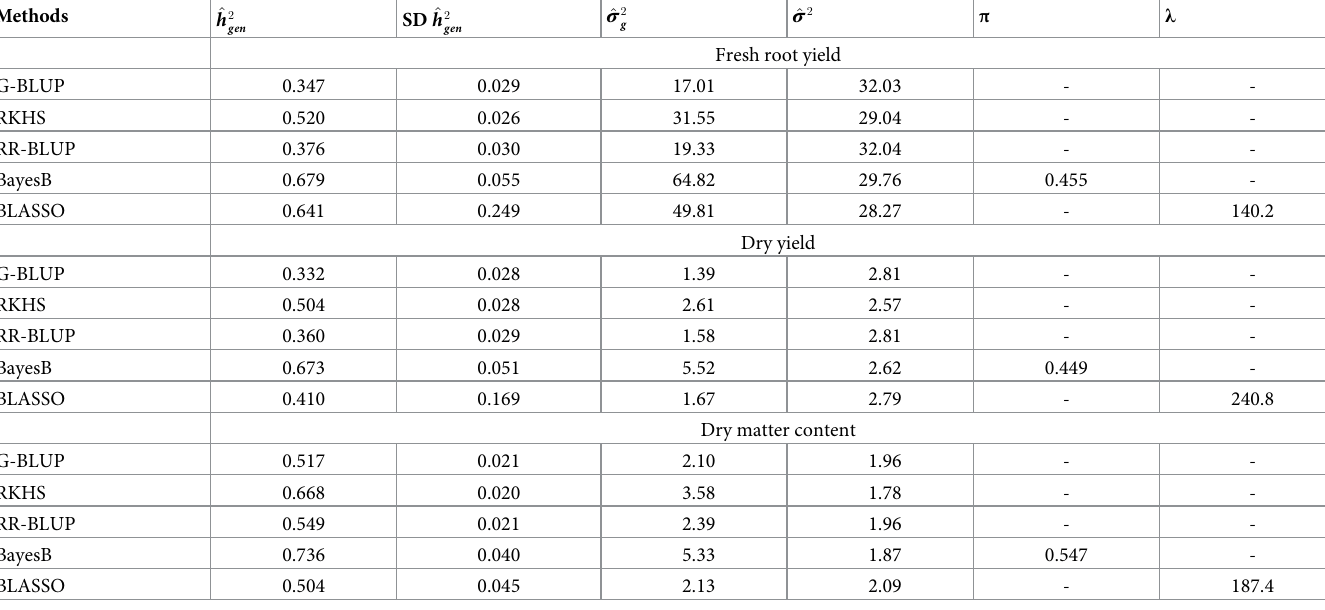
Table 1. A posteriori means for genomic estimates of fresh root yield, dry root yield and dry matter content for the first cross-validation strategy. Methods